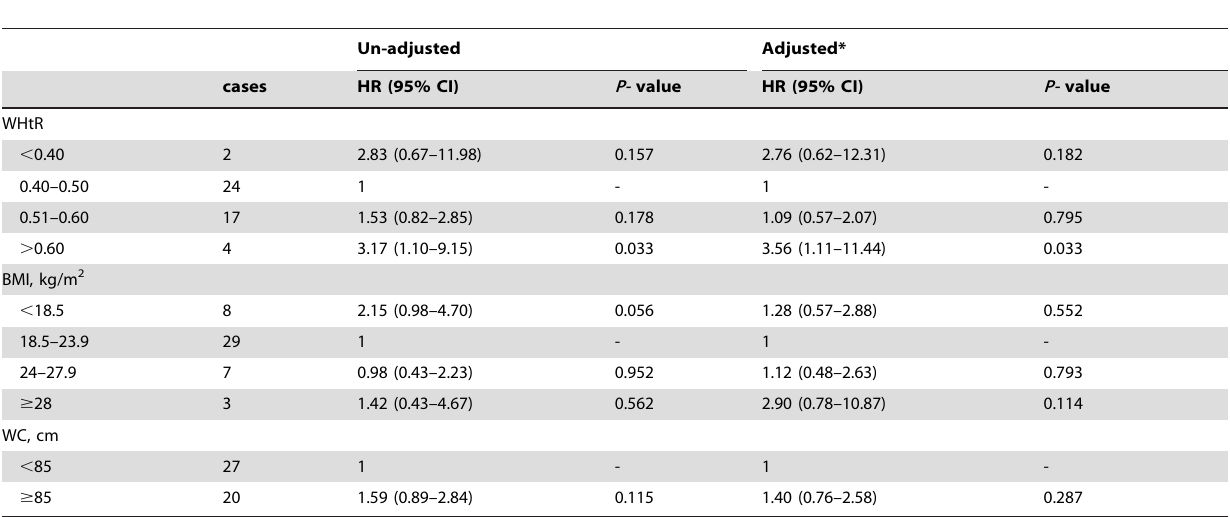
Table 2. Hazard Ratios and 95% Confidence Intervals of Ischemic Stroke associated with different Values of WHtR, BMI and WC.